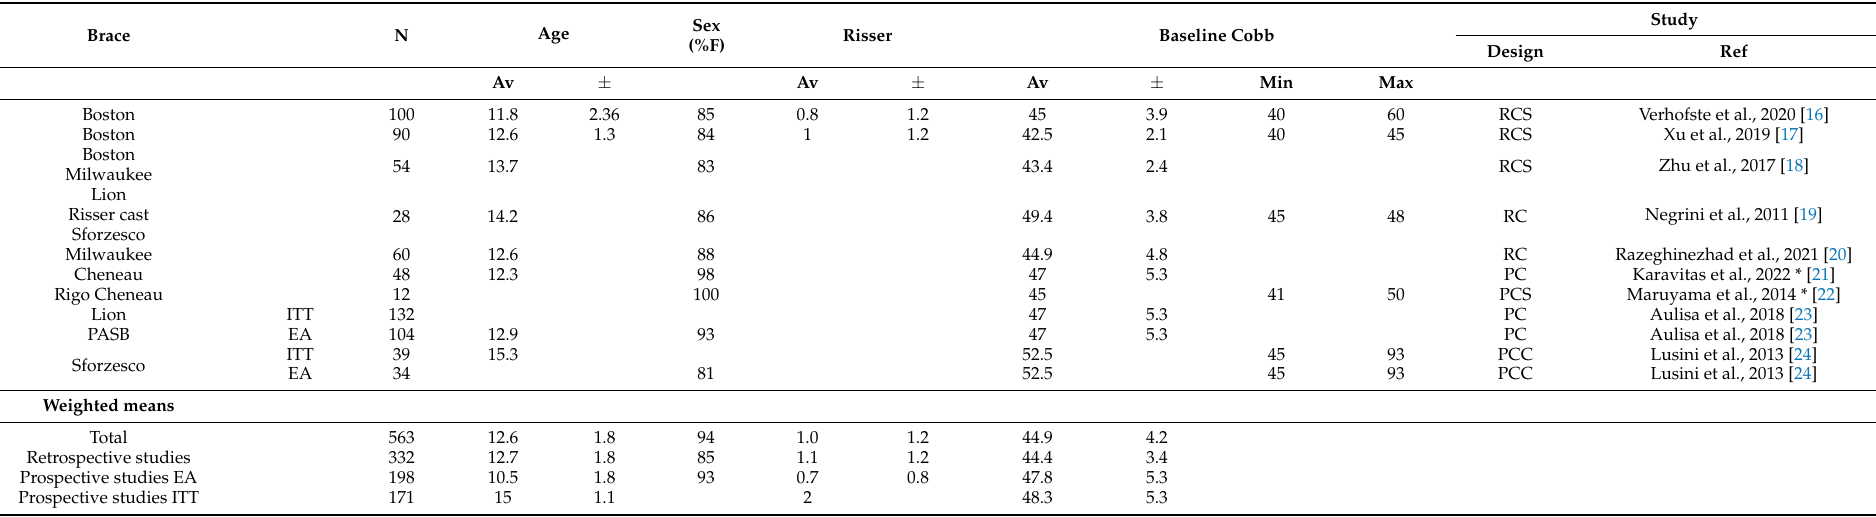
Table 1. Characteristic of the included